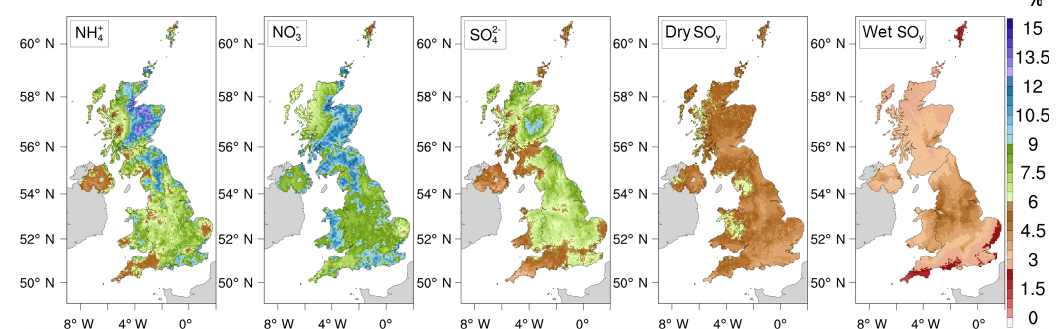
Figure 5. Spatial distributions (at the 5km × 5km model grid resolution) of the relative uncertainties in surface concentrations of particulate NH + , SO 2 − , NO − , and dry and wet deposition of SO y for uncertainties of ± 4, ± 10, ± 20% in emissions of SO 2 , NO x , and NH 3 respectively. 4 4 3 The uncertainty values are represented as a range of ± the baseline value and represent the 95% confidence